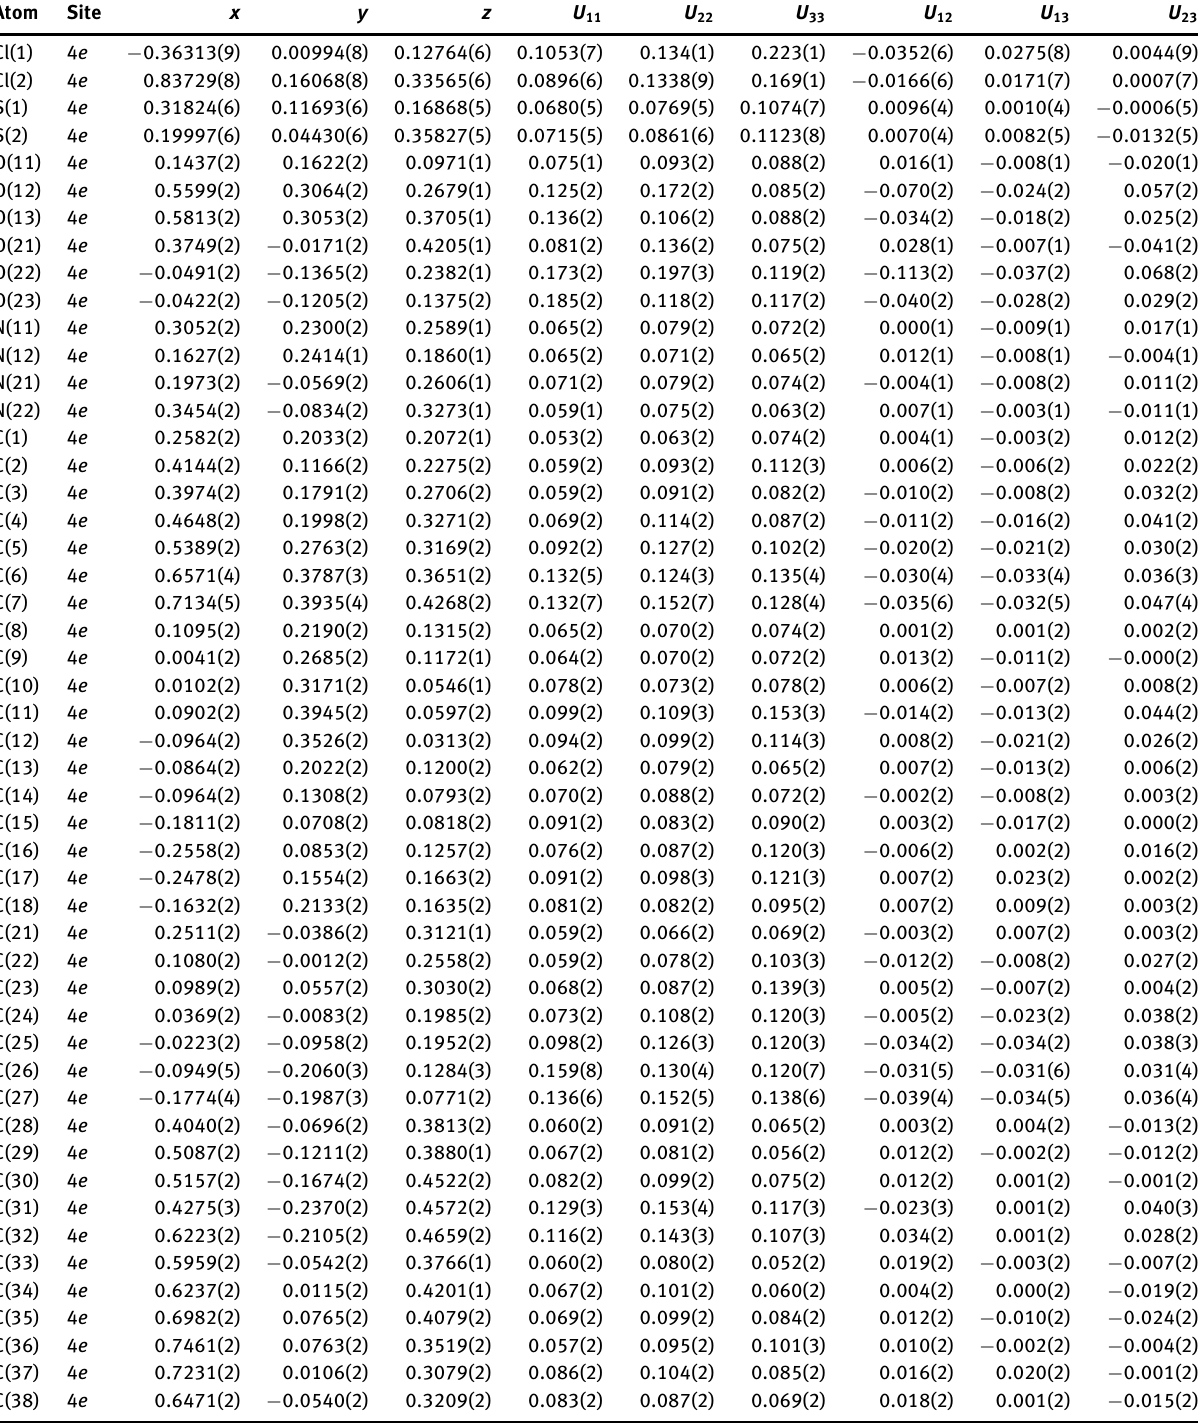
Table 3: Atomic displacement parameters (Å 2